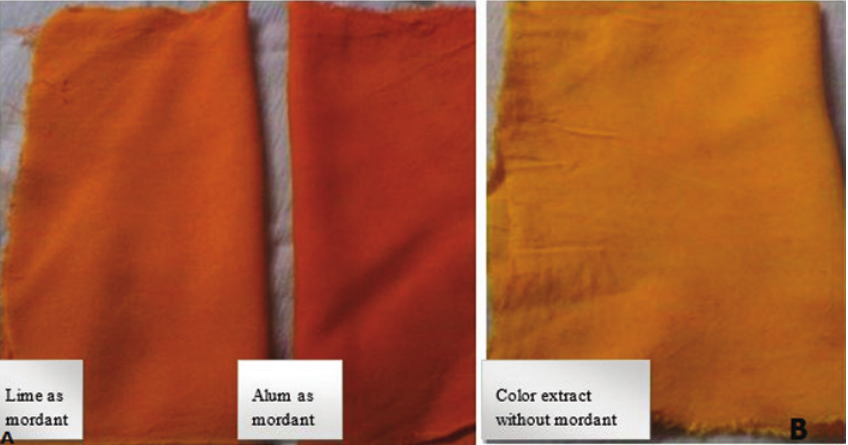
Figure 8: Application of color extracted from Curcuma longa . (A) Change in colour when applied Lime and Alum as mordant (B) Colour effect without mordant.